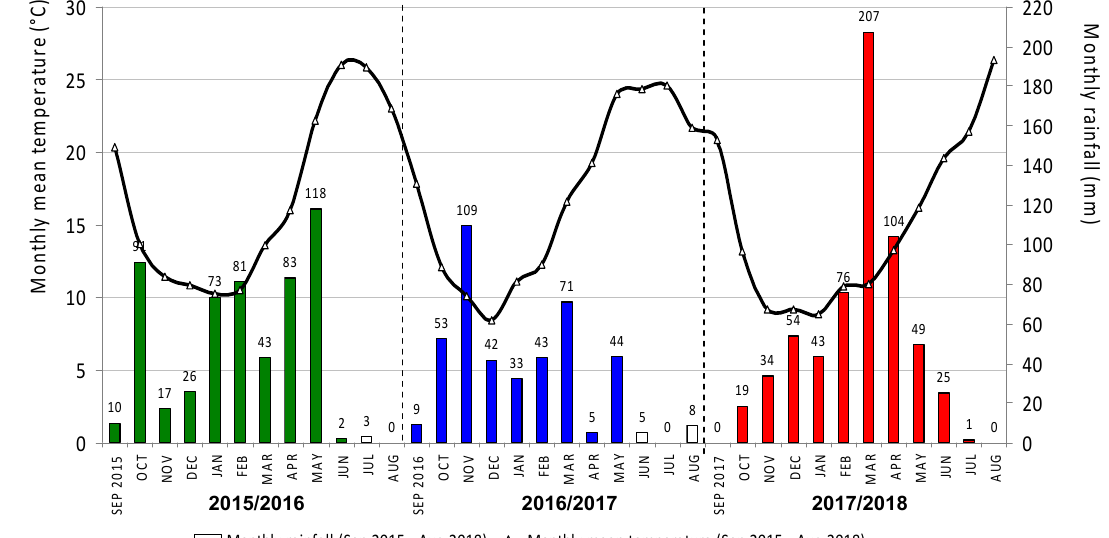
Figure 3. Monthly mean temperature and monthly rainfall in the meteorological station of Mitra (Évora, Portugal), between September 2015 and August 2018.